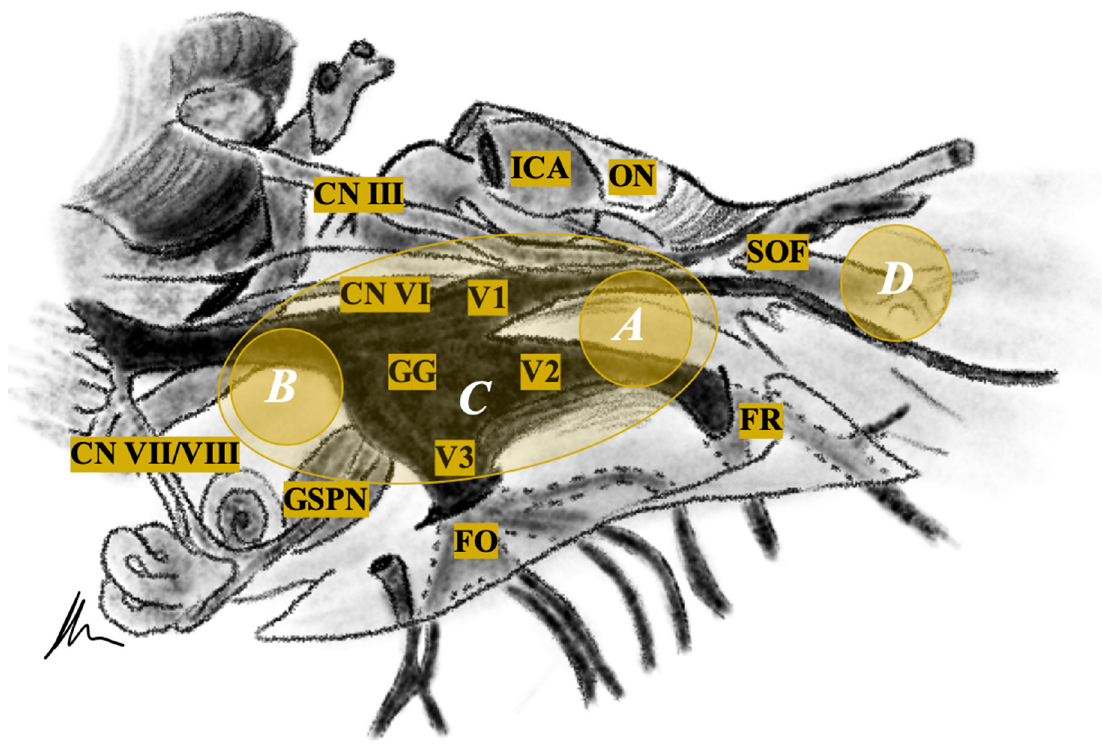
Figure 1. Schematic representation of the trigeminal nerve, its branches, their anatomical localization, adjacent neurovascular structures and tumor classification (white letters). CN = Cranial Nerve, FO = Foramen Ovale, FR = Foramen Rotundum, GG = Gasserian Ganglion, GSPN = Greater Superficial Petrosal Nerve, ICA = Internal Carotid Artery, ON = Optic Nerve, SOF = Superior Orbital Fissure, V1 = Ophthalmic Division, V2 = Maxillary Division, V3 = Mandibular Division.